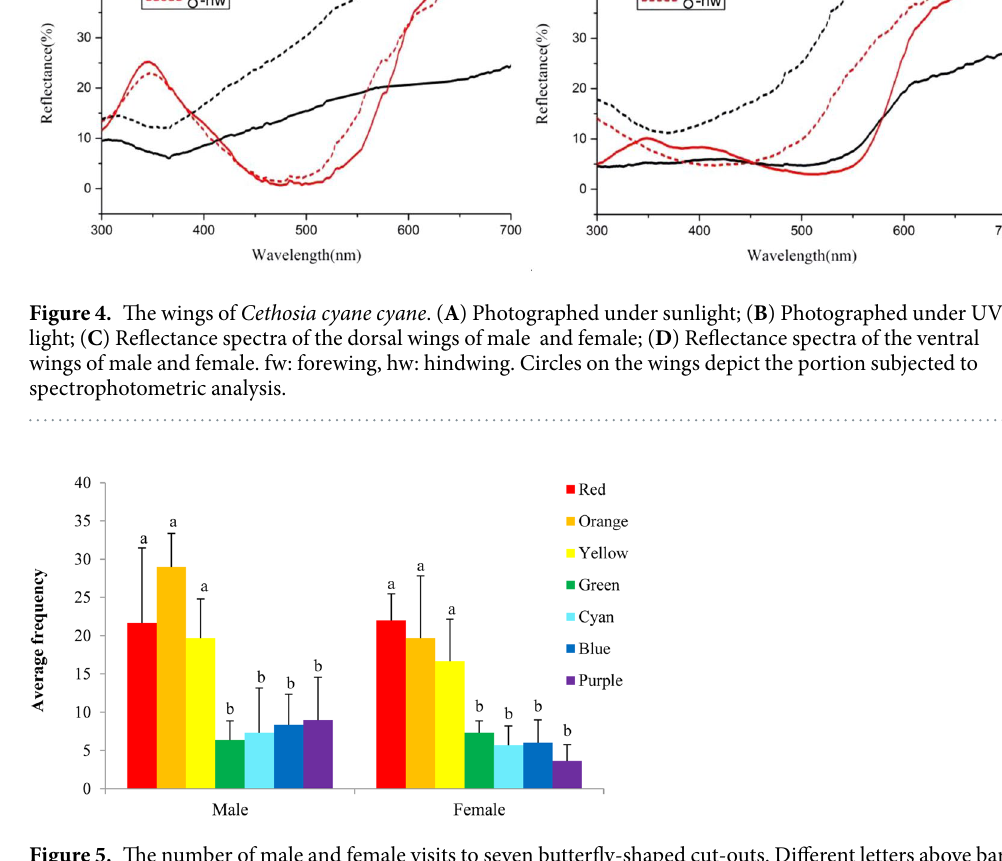
concentrations of cedrol were significantly different between females and males ( P = 0.033), but there were no significant differences between their responses to heneicosane and linalool oxide either at low or high concen- trations ( P > 0.05). Therefore, we speculated that cedrol might be involved in the precise identification of females by males.